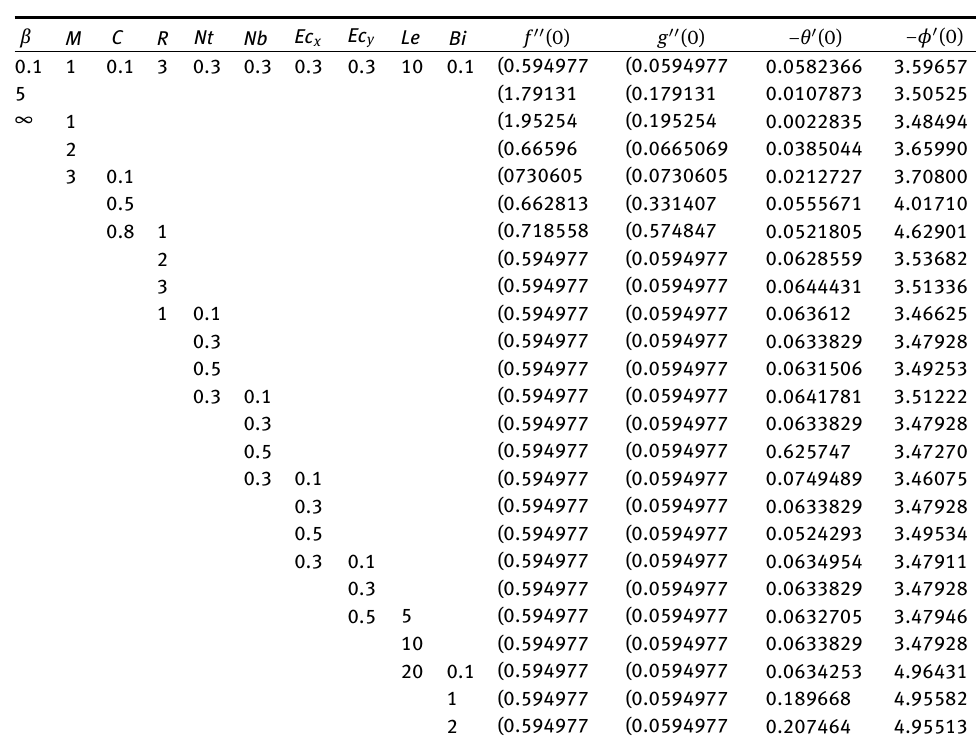
Table 3: Variations of f (cid:48)(cid:48) (0), g (cid:48)(cid:48) (0), − θ (cid:48) (0) and − ϕ (cid:48) (0) with different values of various parameters when Pr = 3, θ w = 1.3 and n = 3. β M C R